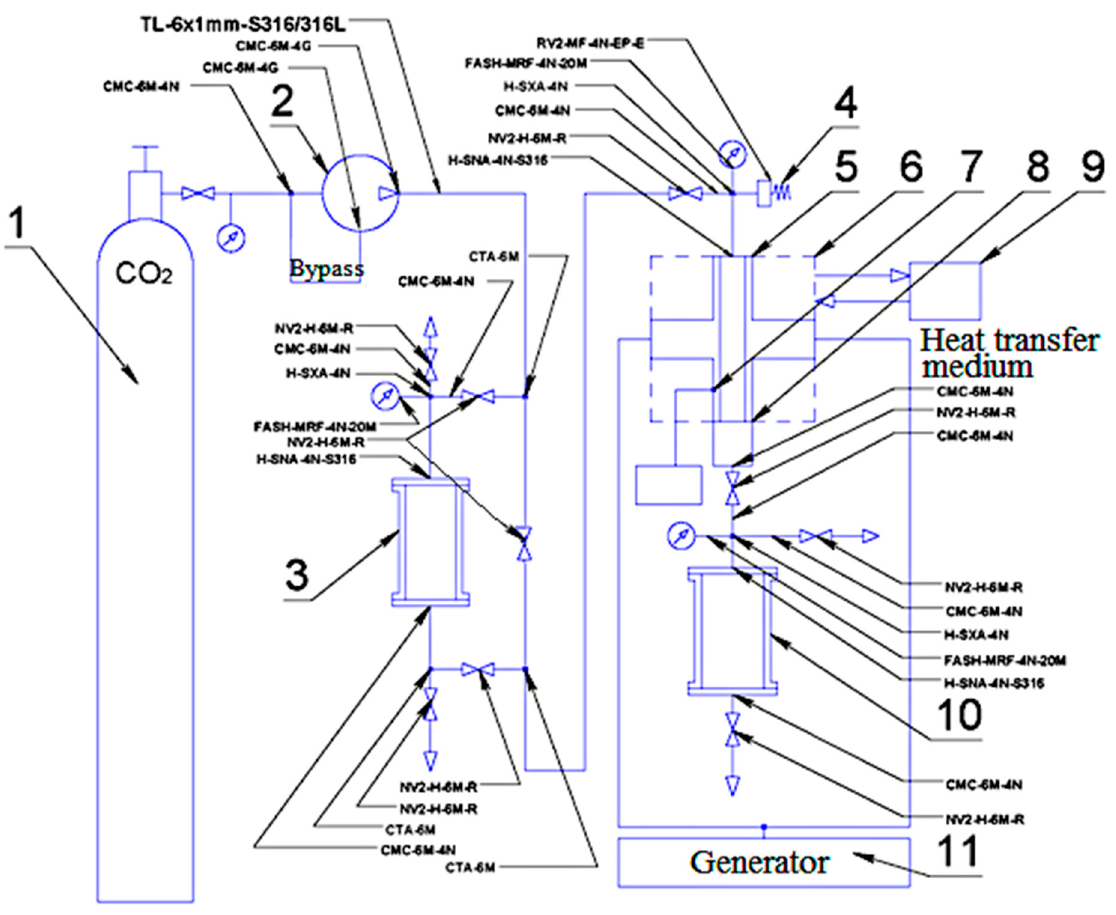
Figure 1. Scheme of the experimental setup. 1: compressed food-grade carbon dioxide cylinder; 2: piston pump; 3: tank for mixing carbon dioxide with water or another liquid; 4: safety relief valve; 5: reactor (cross-shaped); 6: heat-exchange zone; 7: temperature sensor; 8: coarse filtration unit (screen); 9: heater/cooler; 10: discharge tank; 11: ultrasonic generator.